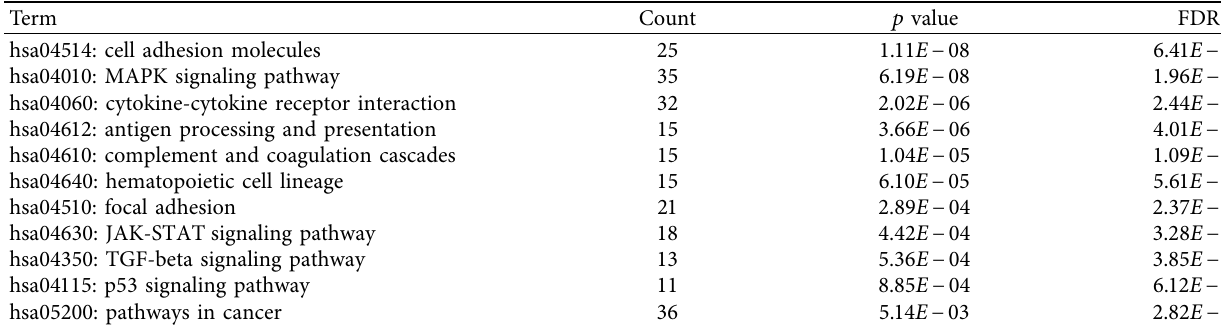
Table 3: The list of DEGs is shown in Table